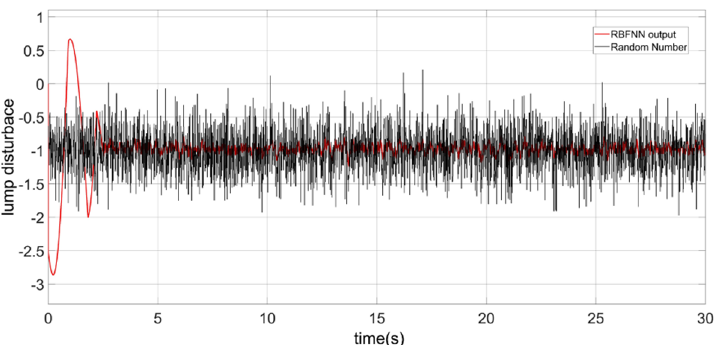
Figure 12. The output of the roll angle RBFNN. The red line is the output of the RBFNN, which could approximate the random lump disturbance with a mean value of −1.